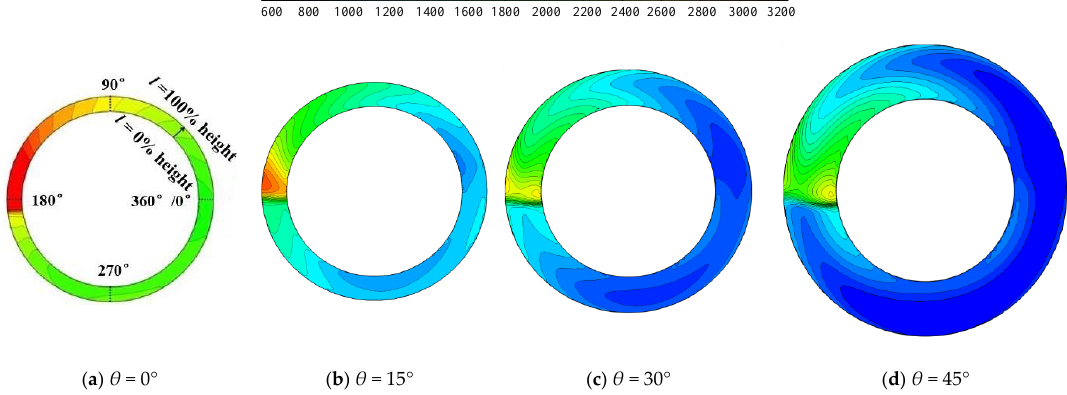
Figure 20. The outlet static temperature contour of the RDC with different θ at t = 3980 μs.